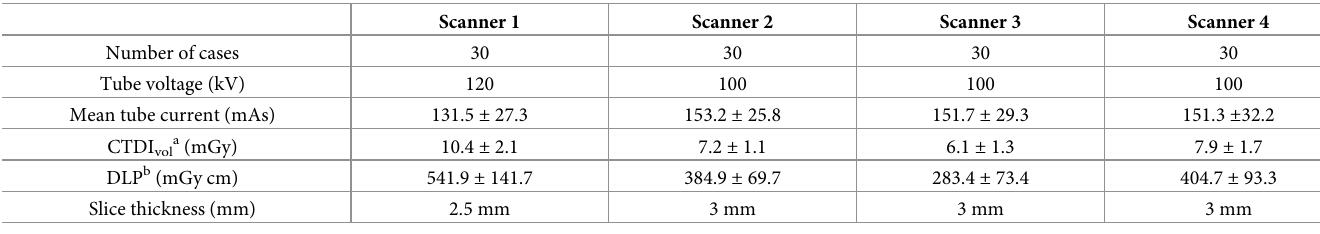
Table 1. Acquisition parameters of CT